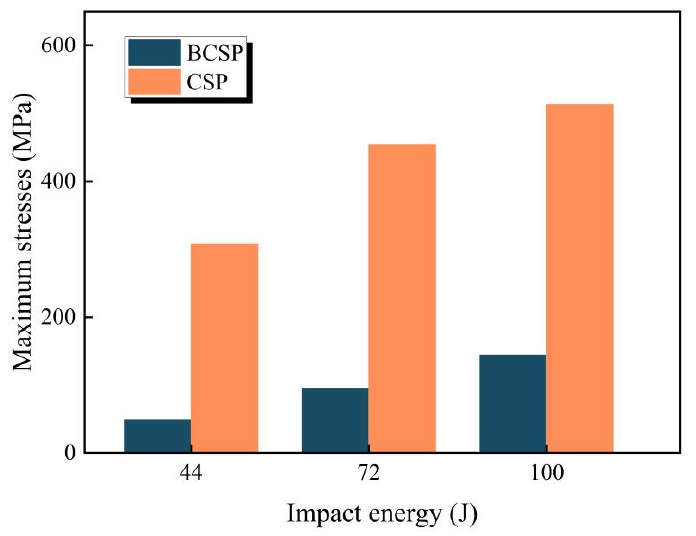
Figure 9. Maximum stresses at the bottom face sheets of the CSP and BCSP under different ener- gies.